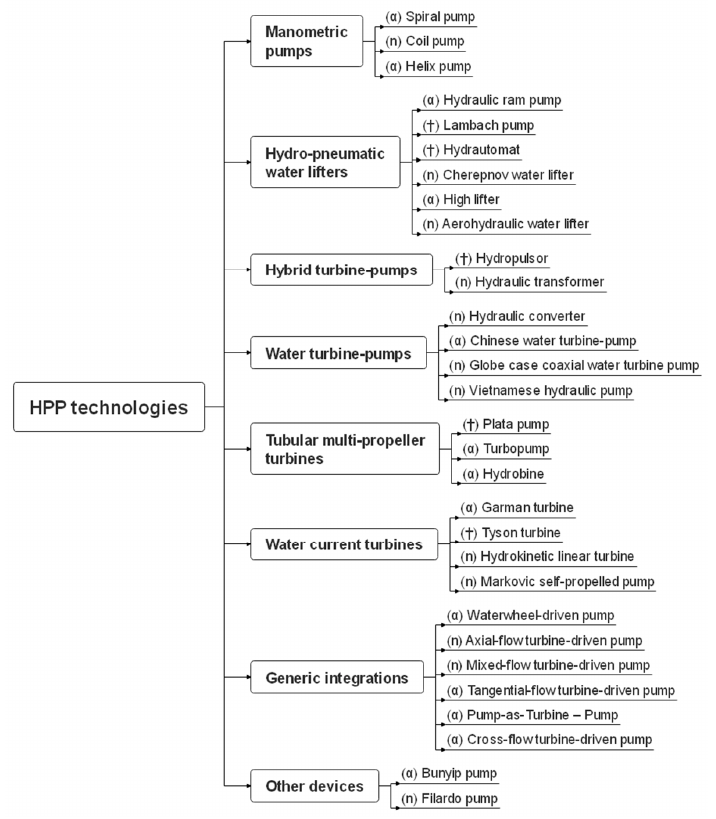
Figure 1. Classification of hydro-powered pumping (HPP) technologies and their latest development/production stage. The symbols ( α ), (†), and (n) stand for commercially available, commercially extinct, and noncommercial technologies, respectively.